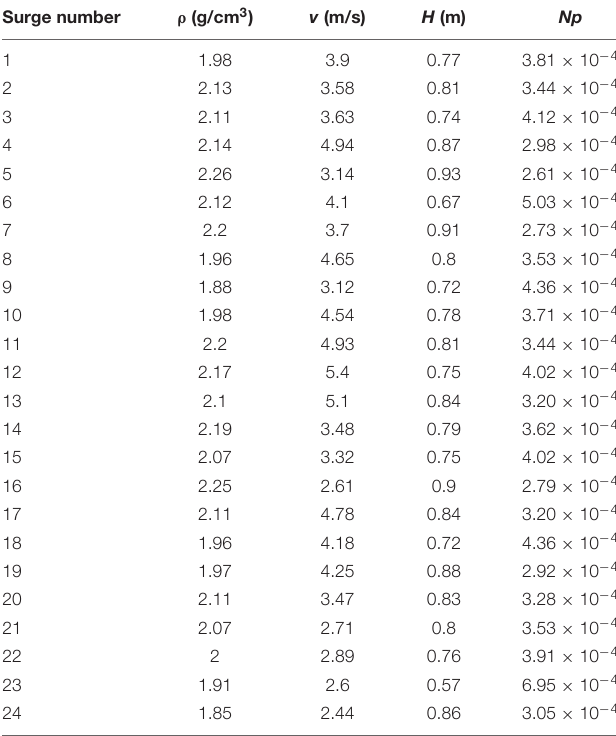
TABLE 1 | Observed quantities of debris flow surges (number according to the order of